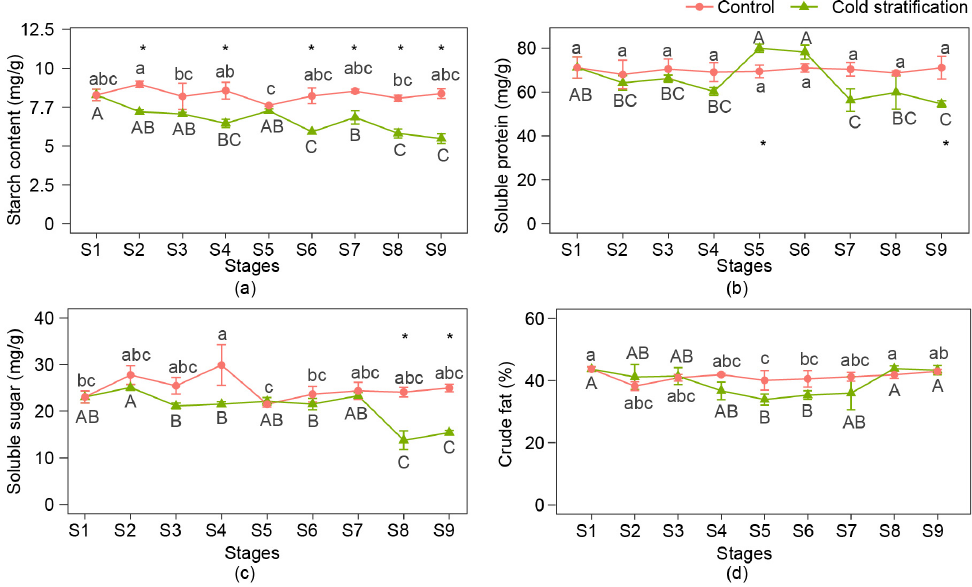
Figure 2. Nutrient content changes in P. emodi seeds during cold stratification. ( a ) Starch content; ( b ) soluble protein content; ( c ) soluble sugar content; ( d ) crude fat content. Note: Lowercase letters represent the significance of differences between stages of control ( p < 0.05); capital letters represent the significance of differences between stages of cold stratification ( p < 0.05); * represents the significant difference between treatments at the same stage ( p < 0.05).